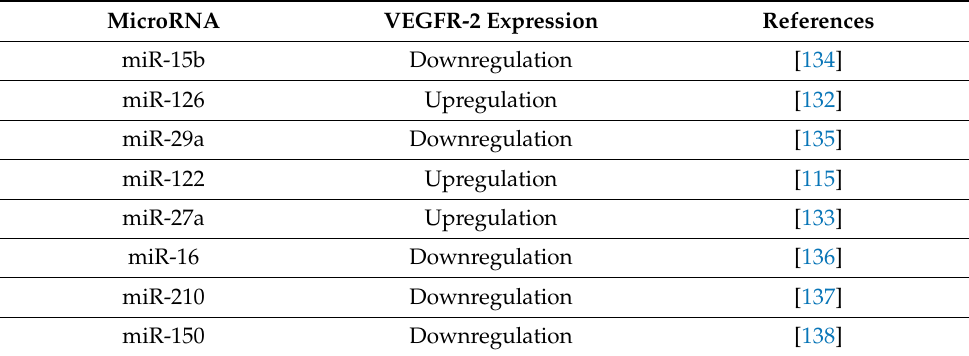
Table 3. The expression of VEGFR-2 in the event of miRNA upregulation.